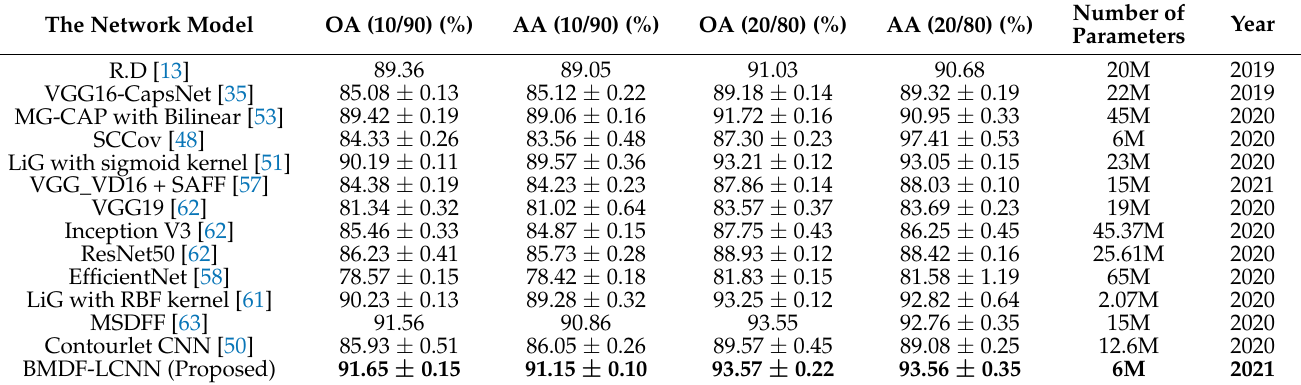
Table 8. Performance comparison of the proposed model with some advanced methods on the NWPU dataset. The Network Model